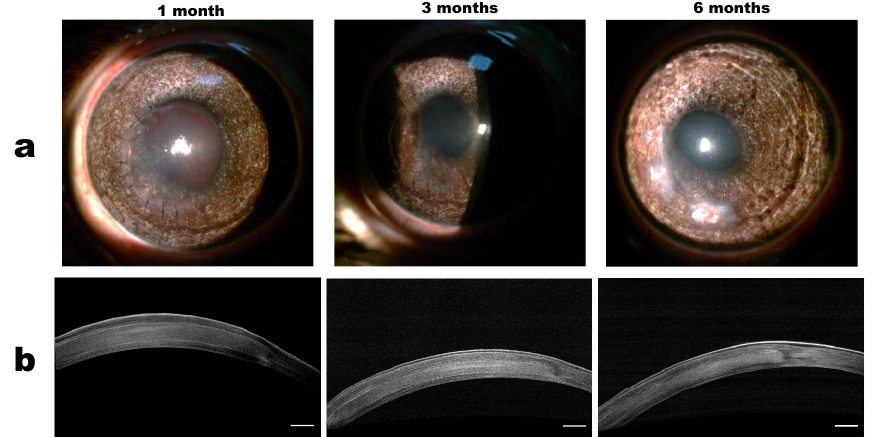
Figure 3. ( a ) Representative photographs of collagen membranes implanted in the stroma at different follow-up times. ( b ) Representative OCT images of rabbit corneas at different follow-up times. Scale bar = 250 µ